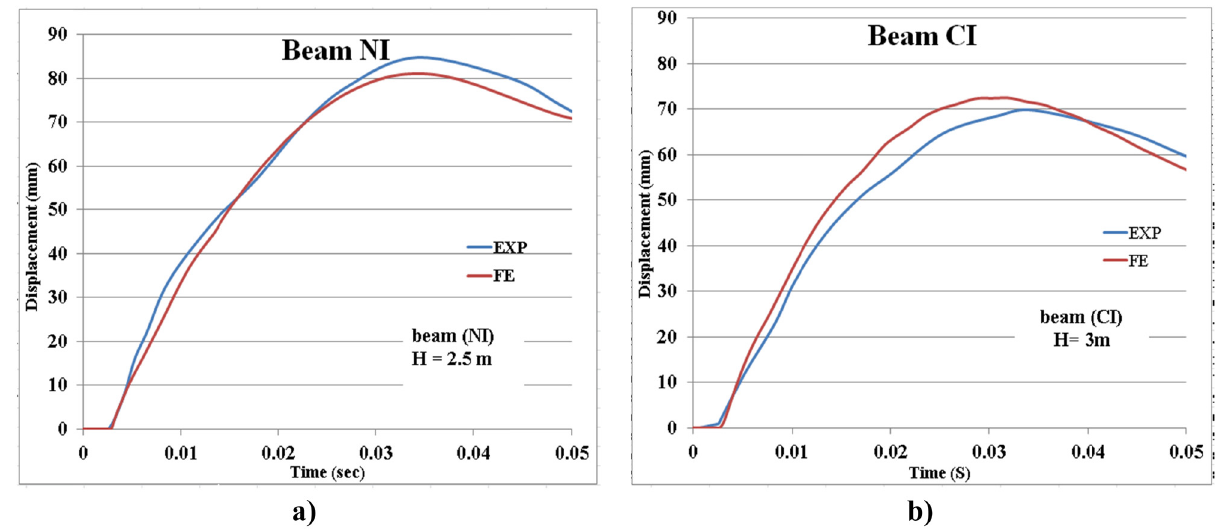
Figure 4: Comparison between the experimental data and numerical results: ( a ) displacement – time history of the beam ( NI ) and ( b ) displacement – time history of the beam ( CI )